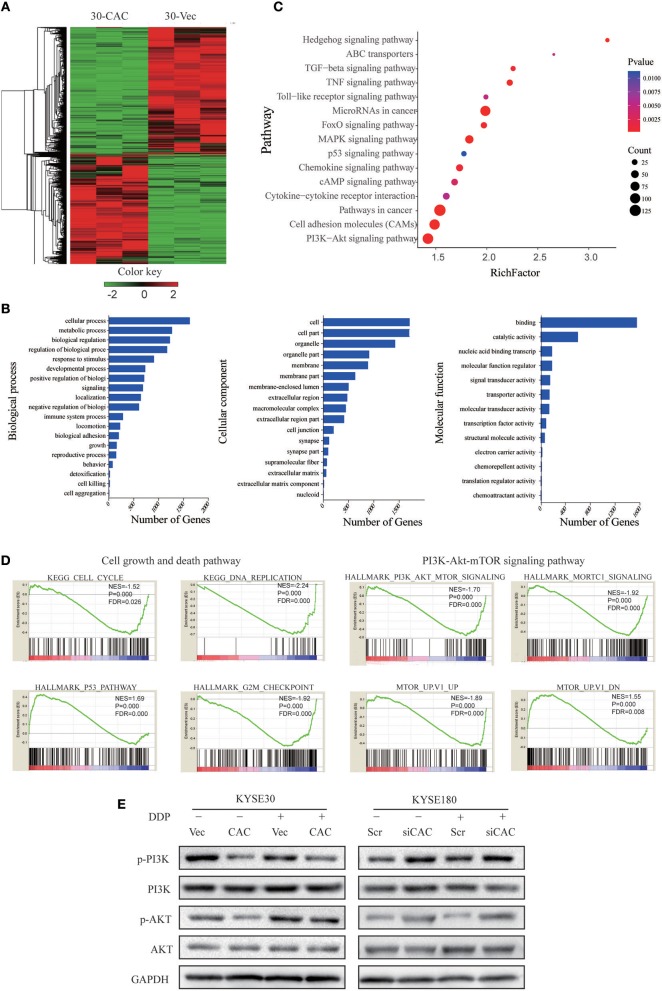
CACANA2D3 regulated the sensitivity of ESCC to cisplatin through inhibiting the PI3K/Akt pathways. (A) DEG heatmap and hierarchical clustering results for CACNA2D3-overexpressing KYSE30 ESCC cells. Red and green indicate high and low gene expression, respectively. (B) GO enrichment analysis of the DEGs. The genes were divided into three categories: cellular component, biological process, and molecular function genes. (C) KEGG pathway enrichment analysis of differentially expressed pathways upon CACNA2D3 overexpression. The ordinates represent the enriched KEGG pathway. p < 0.05 was considered statistically significant. (D) GSEA analysis of differentially expressed pathways upon CACNA2D3 overexpression. NES, normalized enrichment score. (E) Levels of P-PI3K, PI3K, P-Akt, and Akt proteins were analyzed by western blotting in CACNA2D3-overexpressing and knockdown cell lines treated with or without cisplatin.